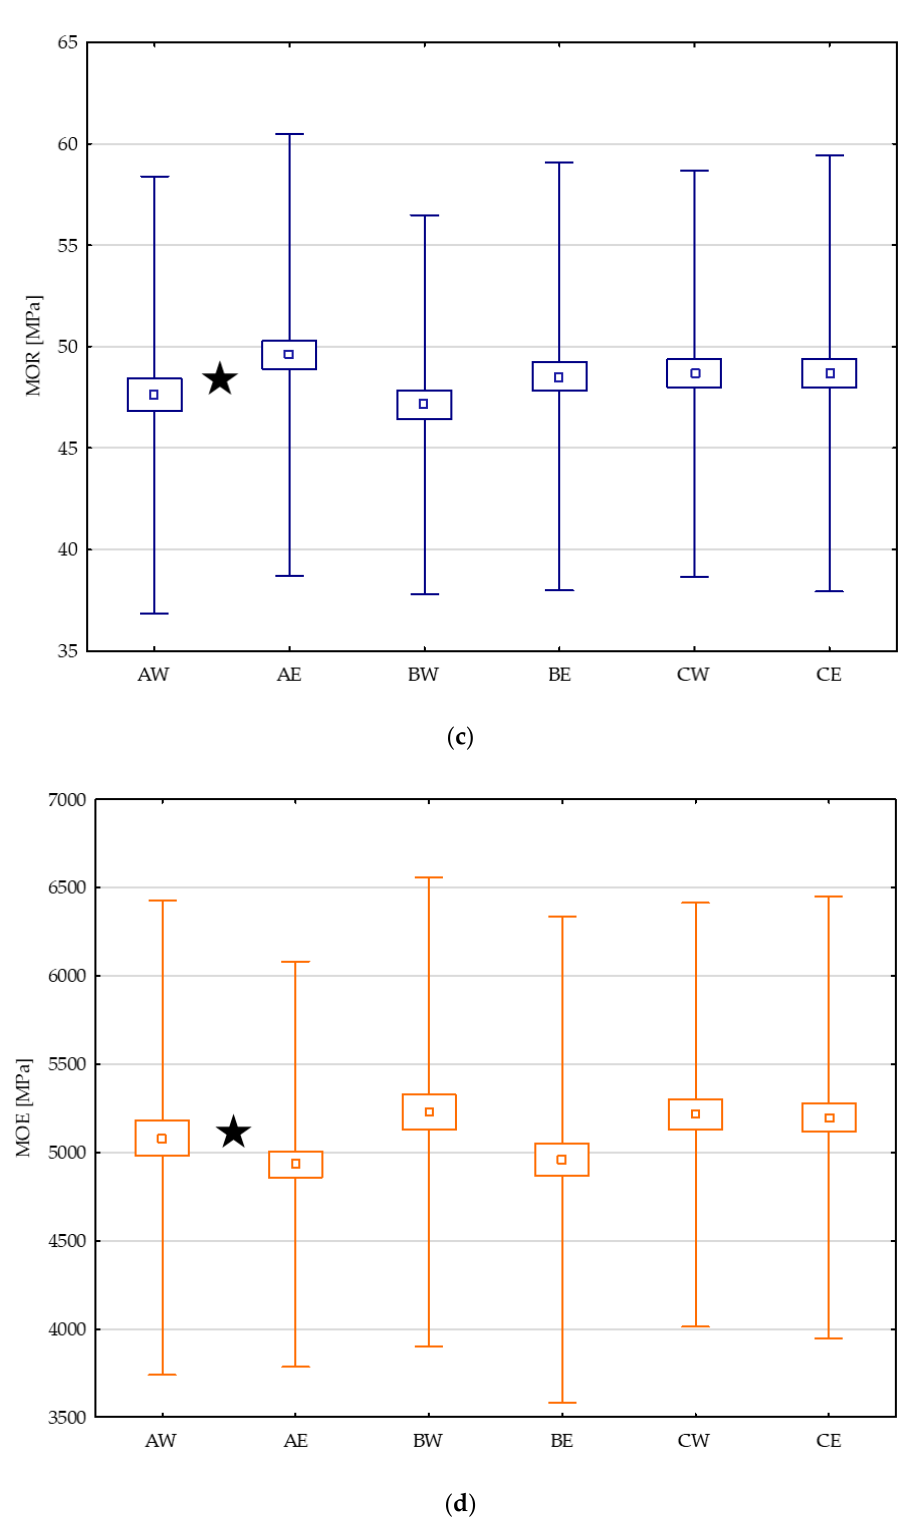
Figure 3. Differences between windward (radius W) and leeward (radius E) side of the tree stem: ( a ) oven-dry density; ( b ) compressive strength longitudinal to grain; ( c ) modulus of rupture (MOR); ( d ) modulus of elasticity (MOE). Note: stars denote a statistically significant difference between radii.